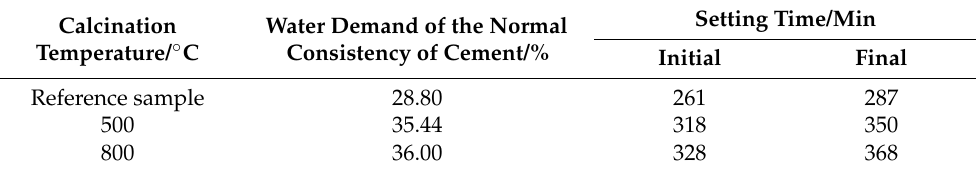
Table 6. The water demand of normal consistency and setting time of the CG sample calcined at different temperatures.